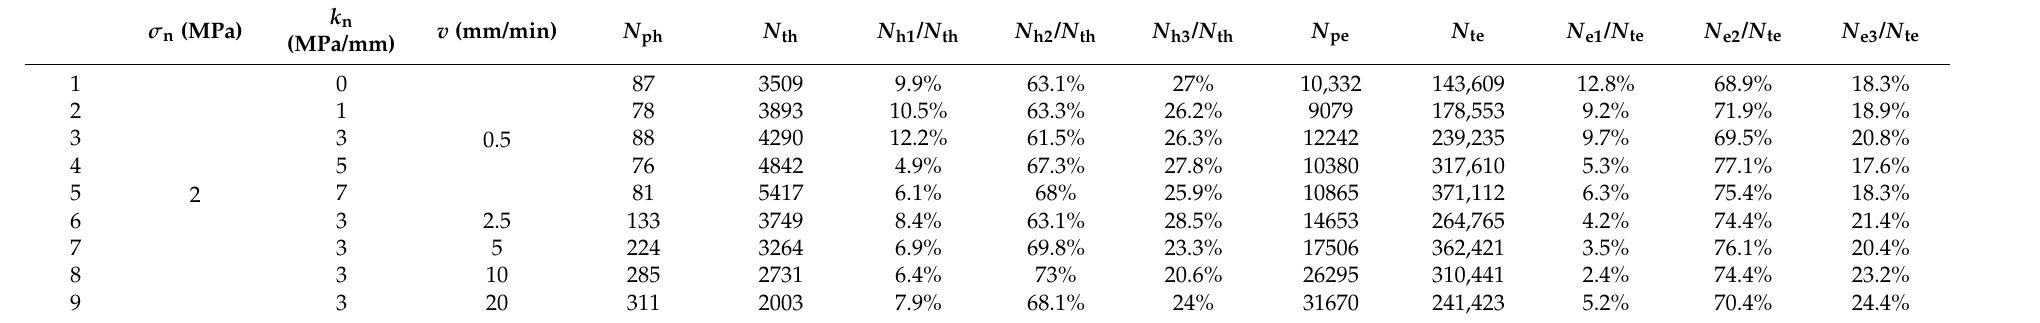
Table 3. Statistics of AE parameters for joints sheared under different test